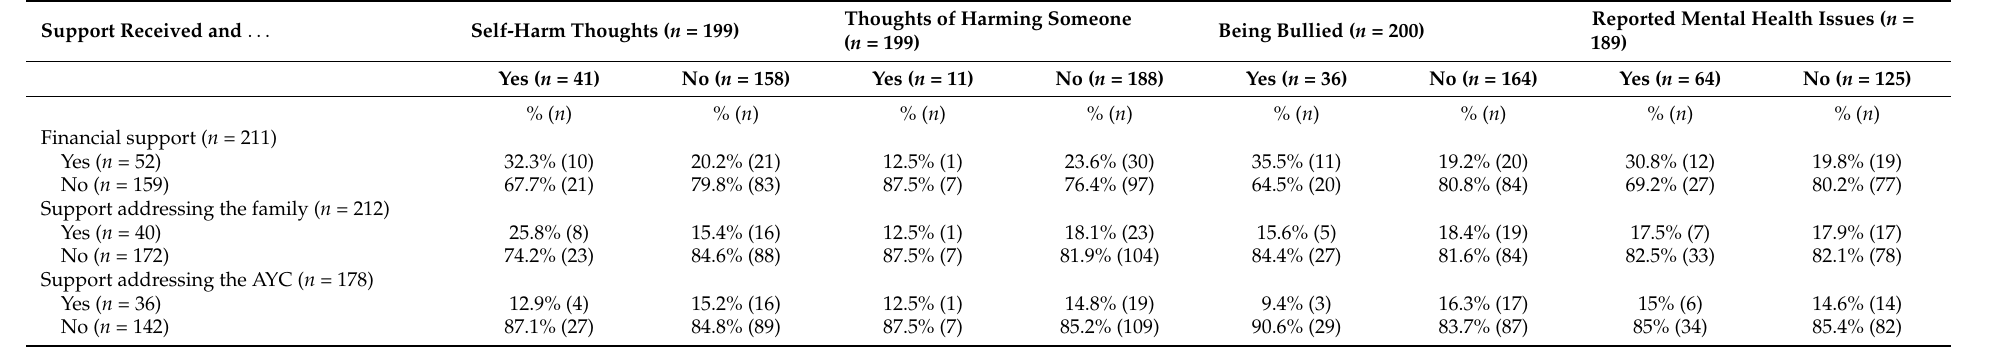
Table 5. Self-harm thoughts, thoughts of harming someone, being bullied, and reported mental health issues by the type of support received. Support Received and . . .